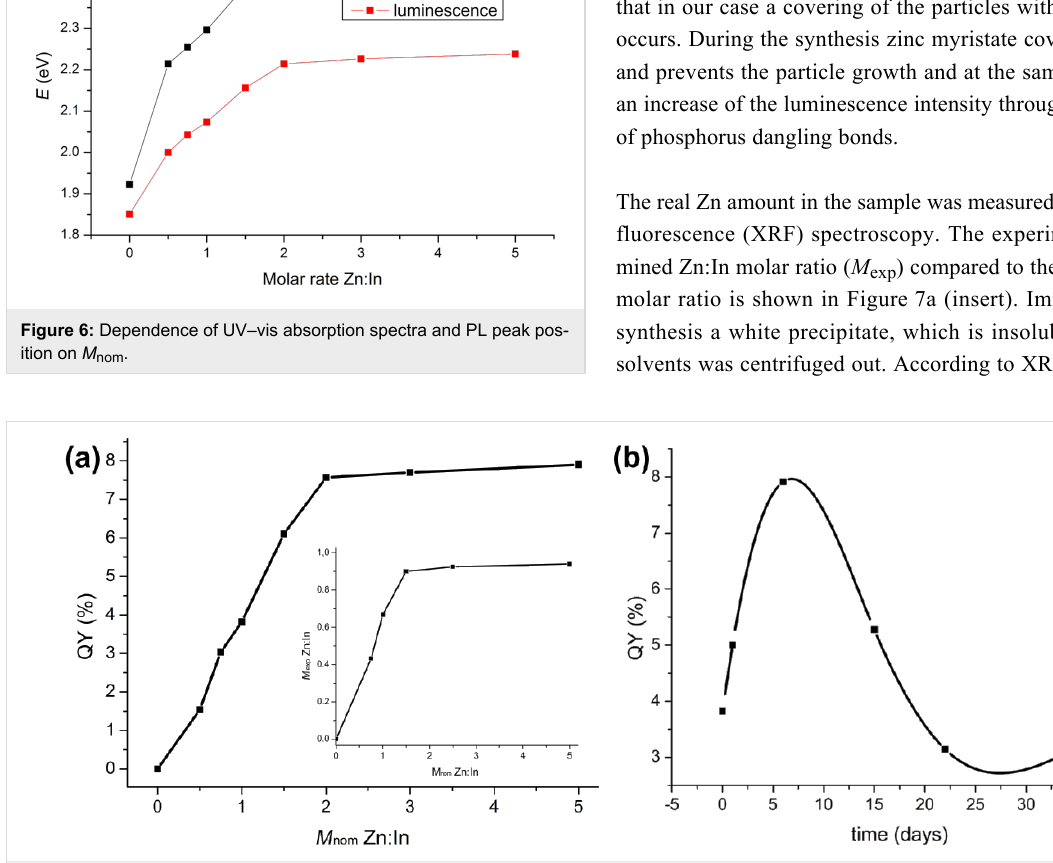
Figure 7: (a) Dependence of QY on M nom ; (insert) dependence of M exp on M nom , obtained from X-ray fluorescence analysis; (b) temporary evolution of luminescence intensity of samle with M nom = 1.